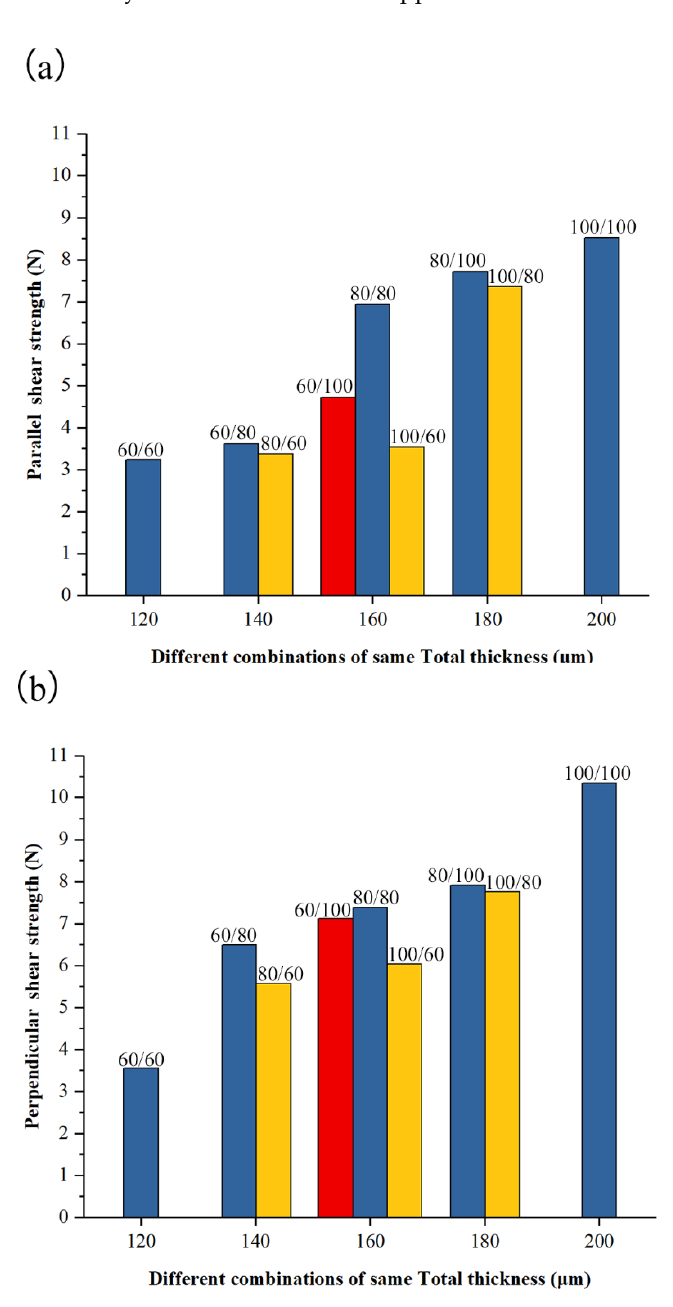
Figure 26. Shear strength of different Al/Al combinations of same total thickness: ( a ) parallel shear strength and ( b ) perpendicular shear strength.